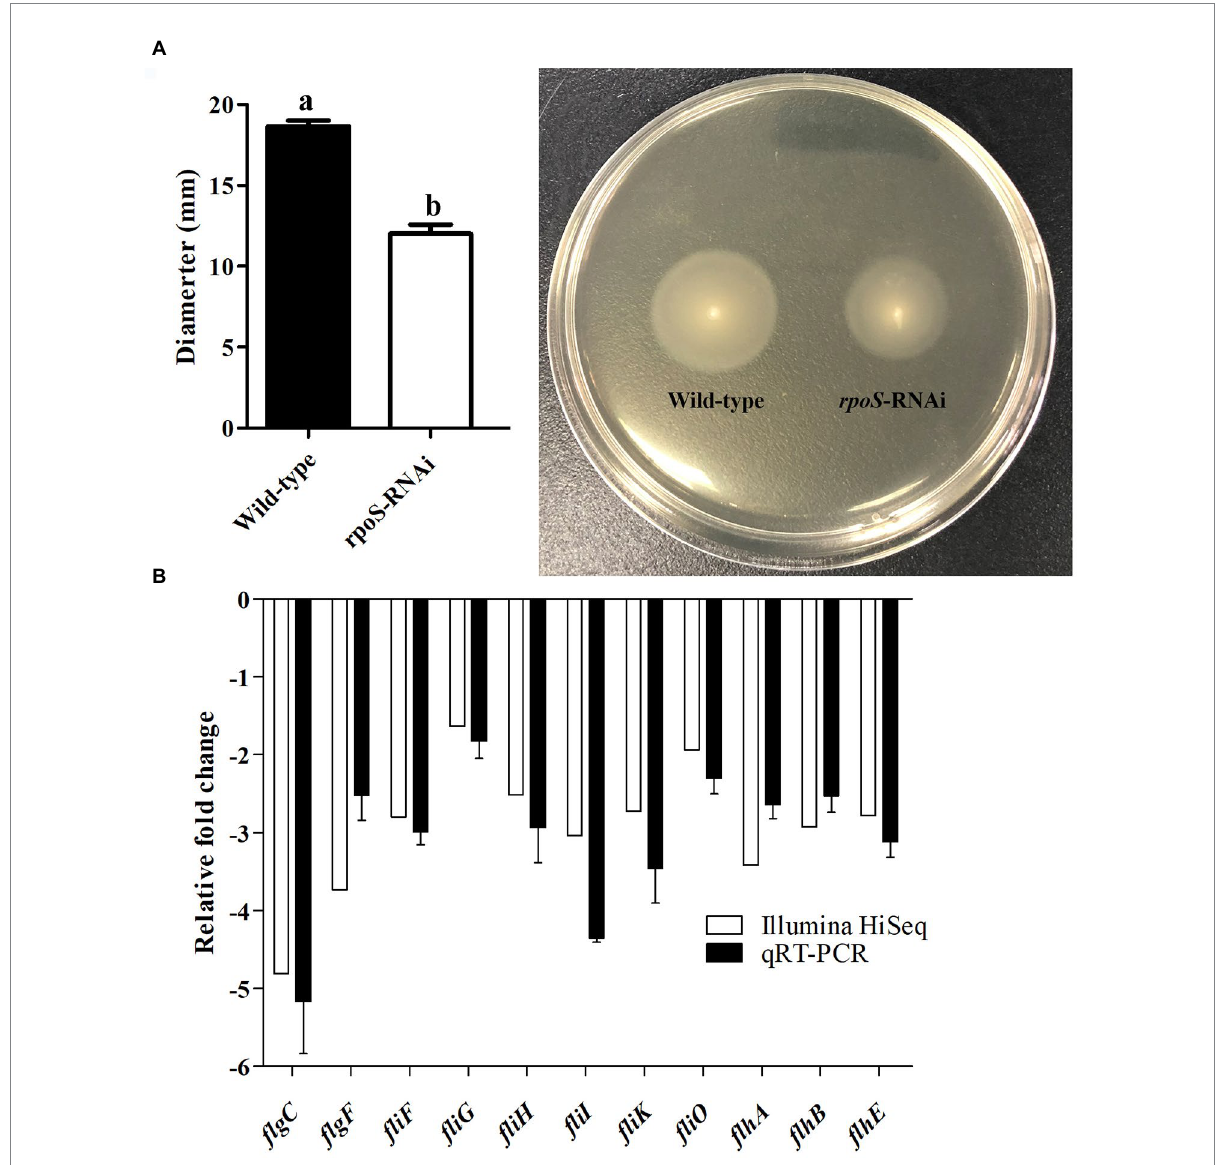
FIGURE 5 Effects of rpoS on motility of Enterobacter cloacae . (A) Detection of motility of E. cloacae wild-type and rpoS -RNAi strains; (B) Expressions of motility-related genes in rpoS -RNAi strain; The values marked with different letters (a, b) are significantly different ( p <